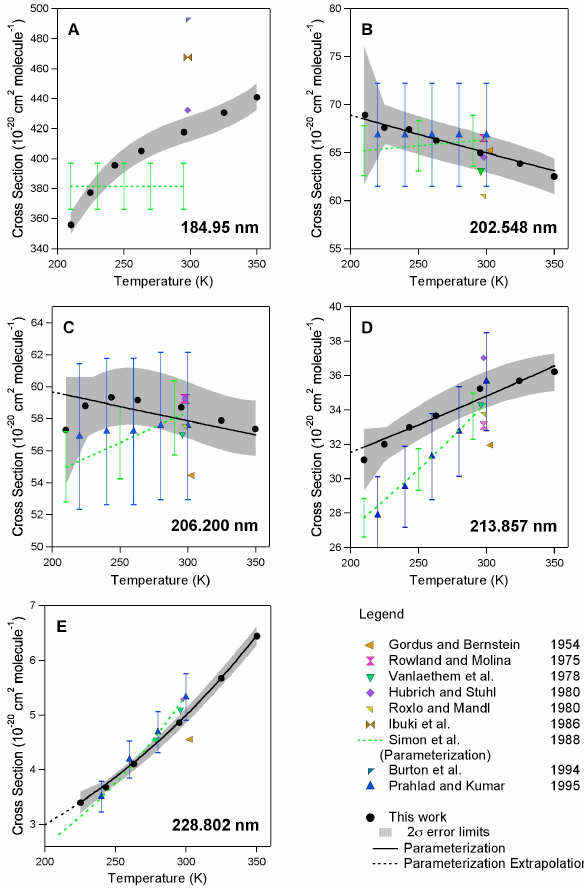
Fig. 3. Temperature dependent CCl 4 absorption cross sections ob- tained in this work ( • ). The shaded region represents the estimated absolute 2 σ (95% confidence level) uncertainty from our work in- cluding estimated systematic errors. Included for comparison are results from previous studies as indicated in the legend. The data from Simon et al. (1988), the data set currently recommended by JPL06-2 (Sander et al., 2006) for use in atmospheric modeling, are plotted using the cross section and temperature dependence param- eterization reported in their work. Data from Causley and Russell (1977), Seccombe et al. (1999), Ho (1998), and Roxlo and Mandl (1980) are not included due to the large deviation from the other